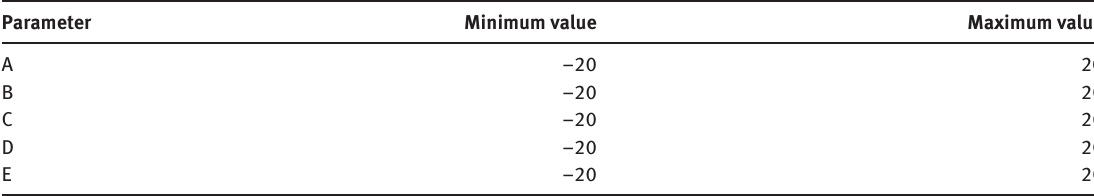
Table 4: Range of Parameters of the Proposed Model. Parameter